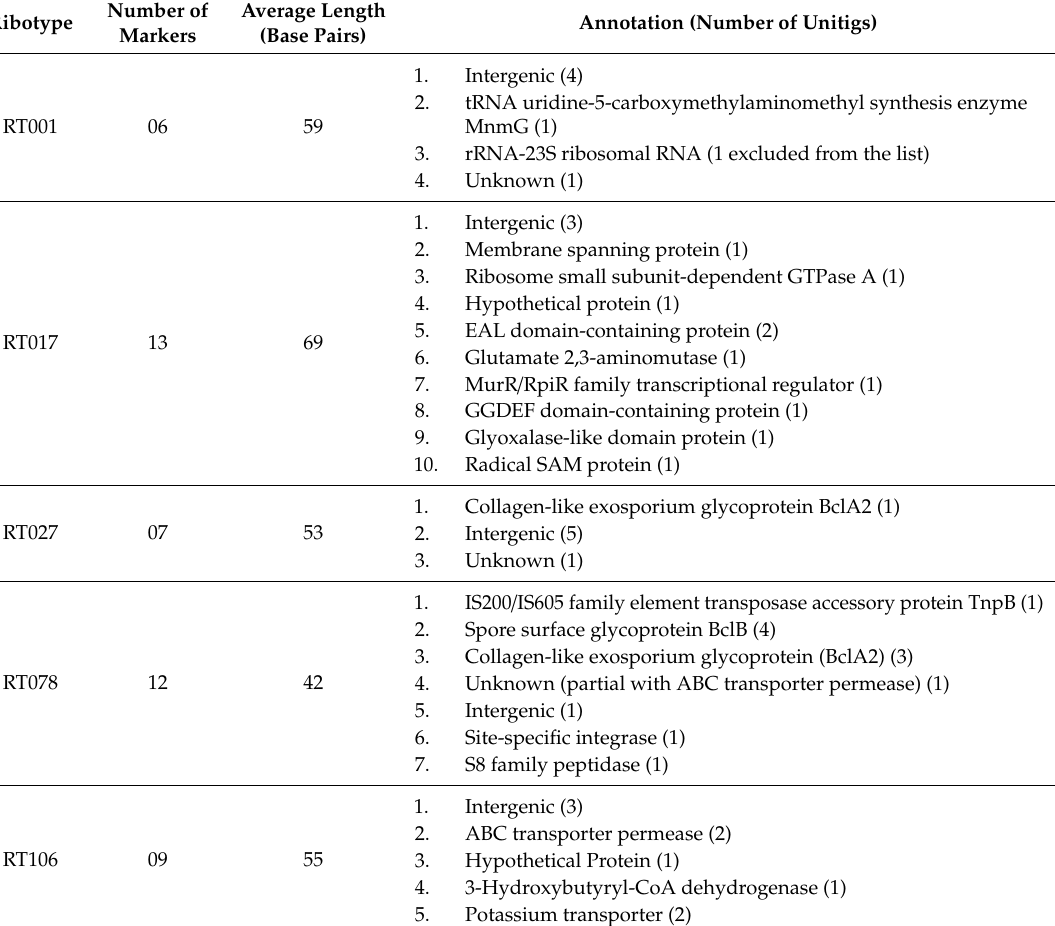
Table 4. Number of unique markers identified for each C. di ffi cile ribotype, their average length, and